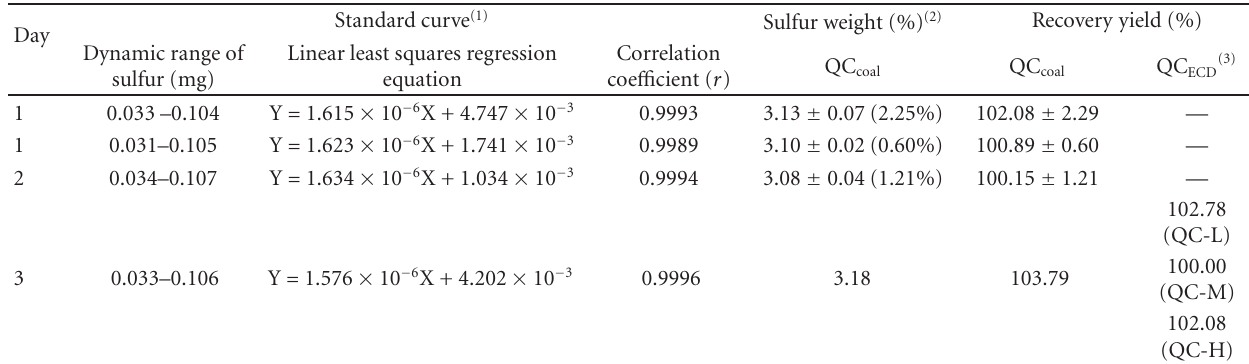
Table 3: Precision and accuracy in the analysis of QC samples and ECD in ECD